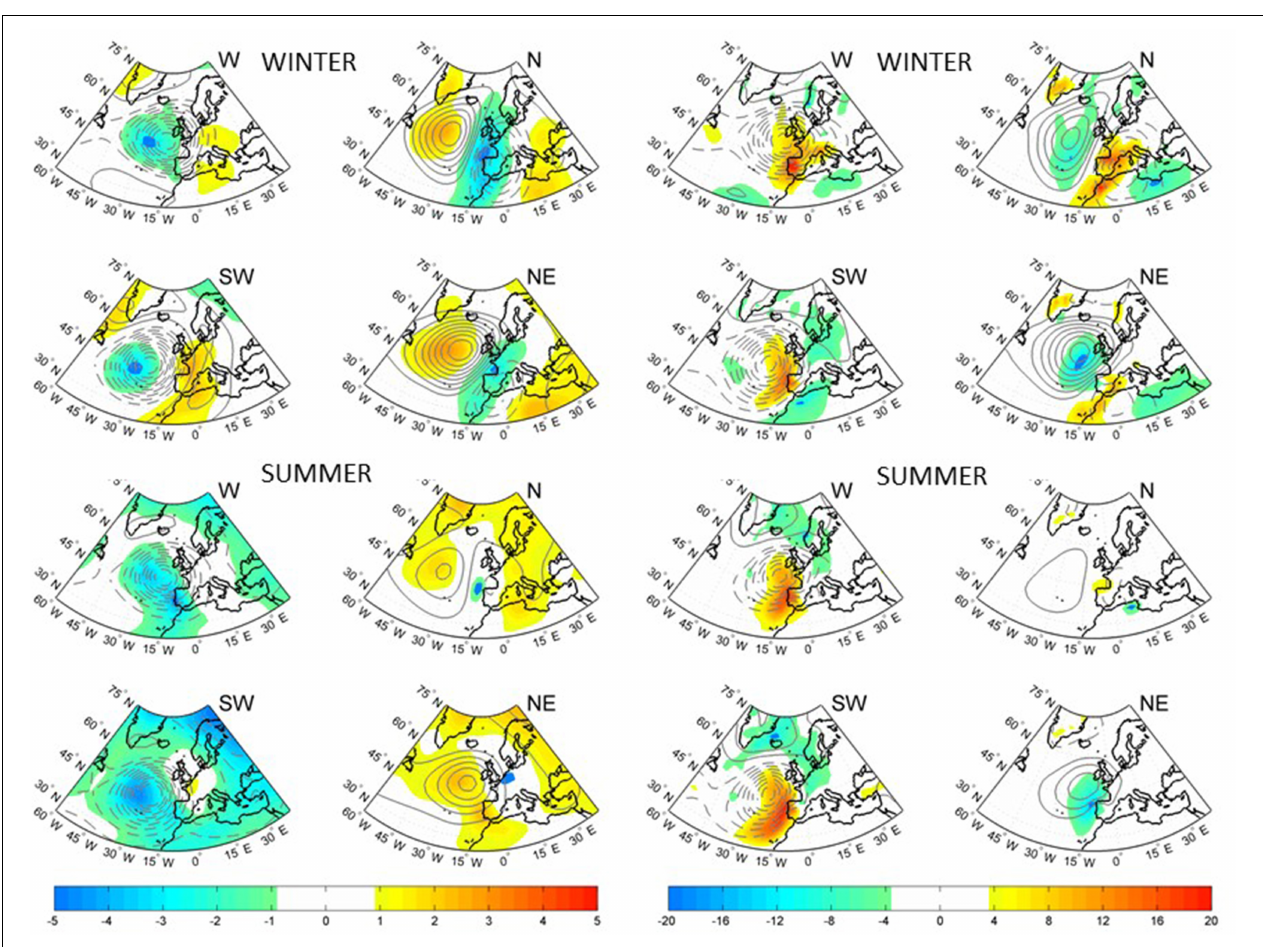
FIGURE 9 | (left) Anomaly composites of HGT (contours; m) at 500 hPa and temperature at 850 hPa (colorbar; ◦ C) in days classified as W, N, SW, and NE. Contour lines every 20m; solid lines represent positive anomalies, dashedlinesrepresentnegativeanomaliesandthezerocontourisomitted.The anomaly fields are shown for winter (top panel) and summer (bottom panel).